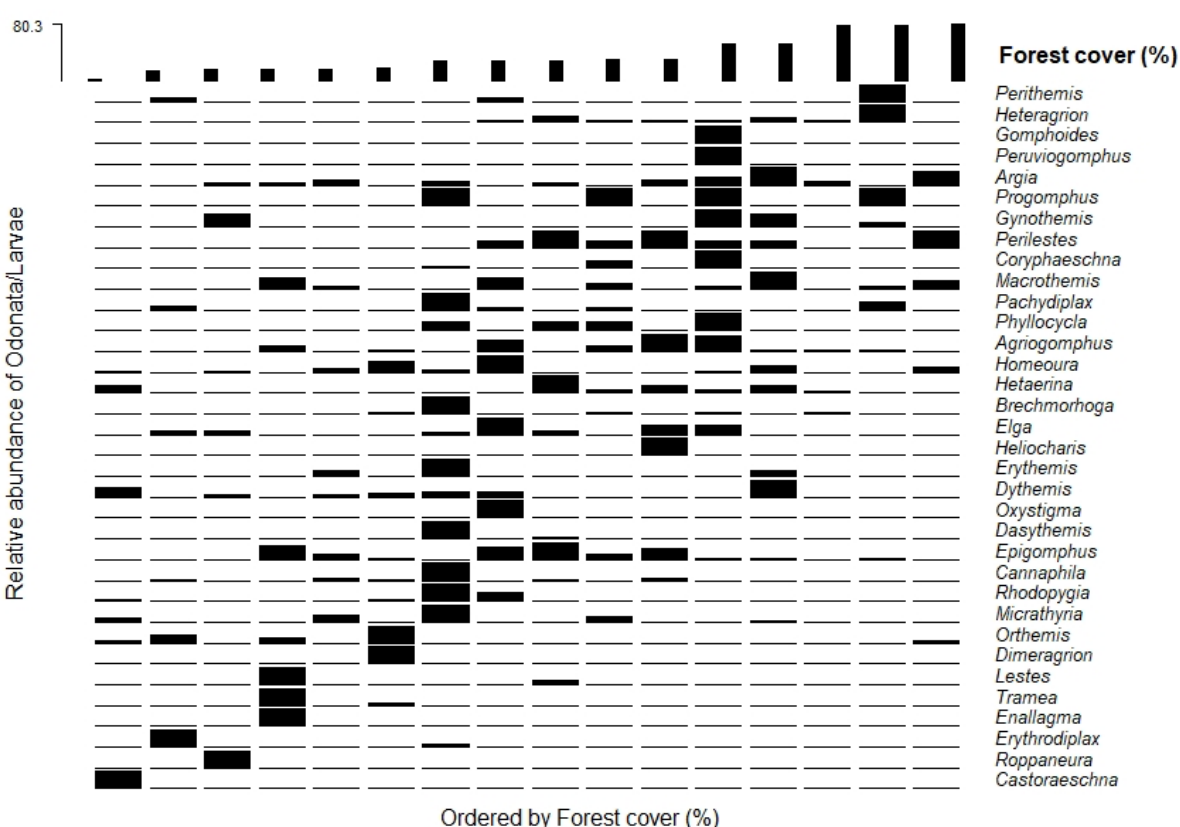
Figure 3. Relative abundance of larvae of Odonata with the amount of forest cover (%) for the streams sampled in cabruca areas.